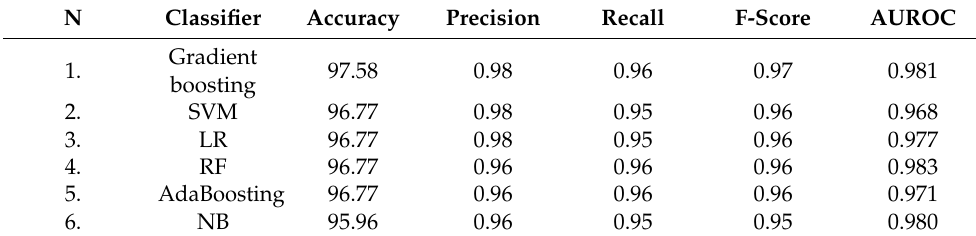
Table 5. Performance results of binary classification of each